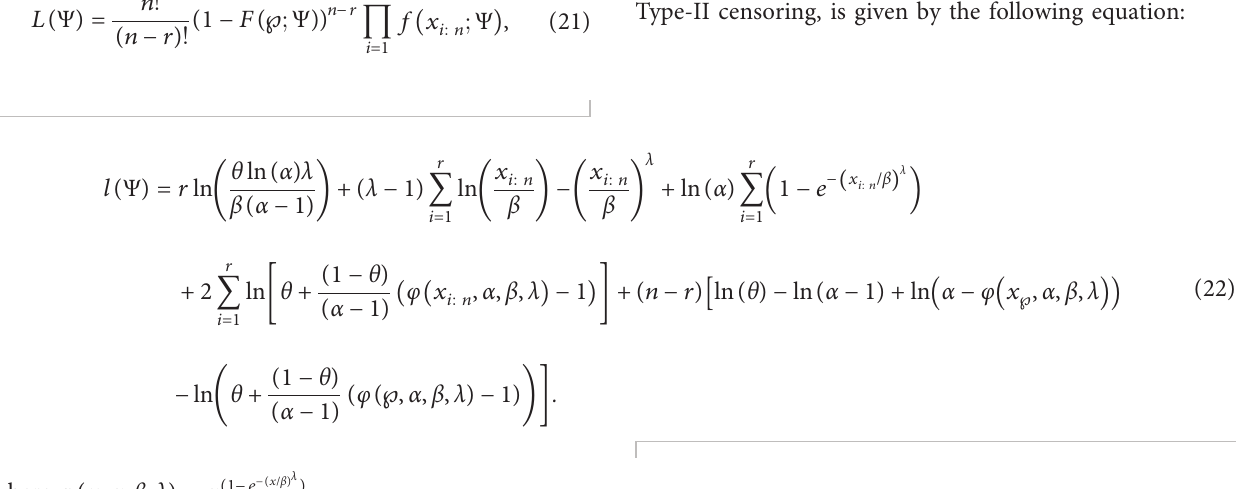
Table 2: the MOAPW has left-skewed, right-skewed, re- versed-J, and symmetric shapes.